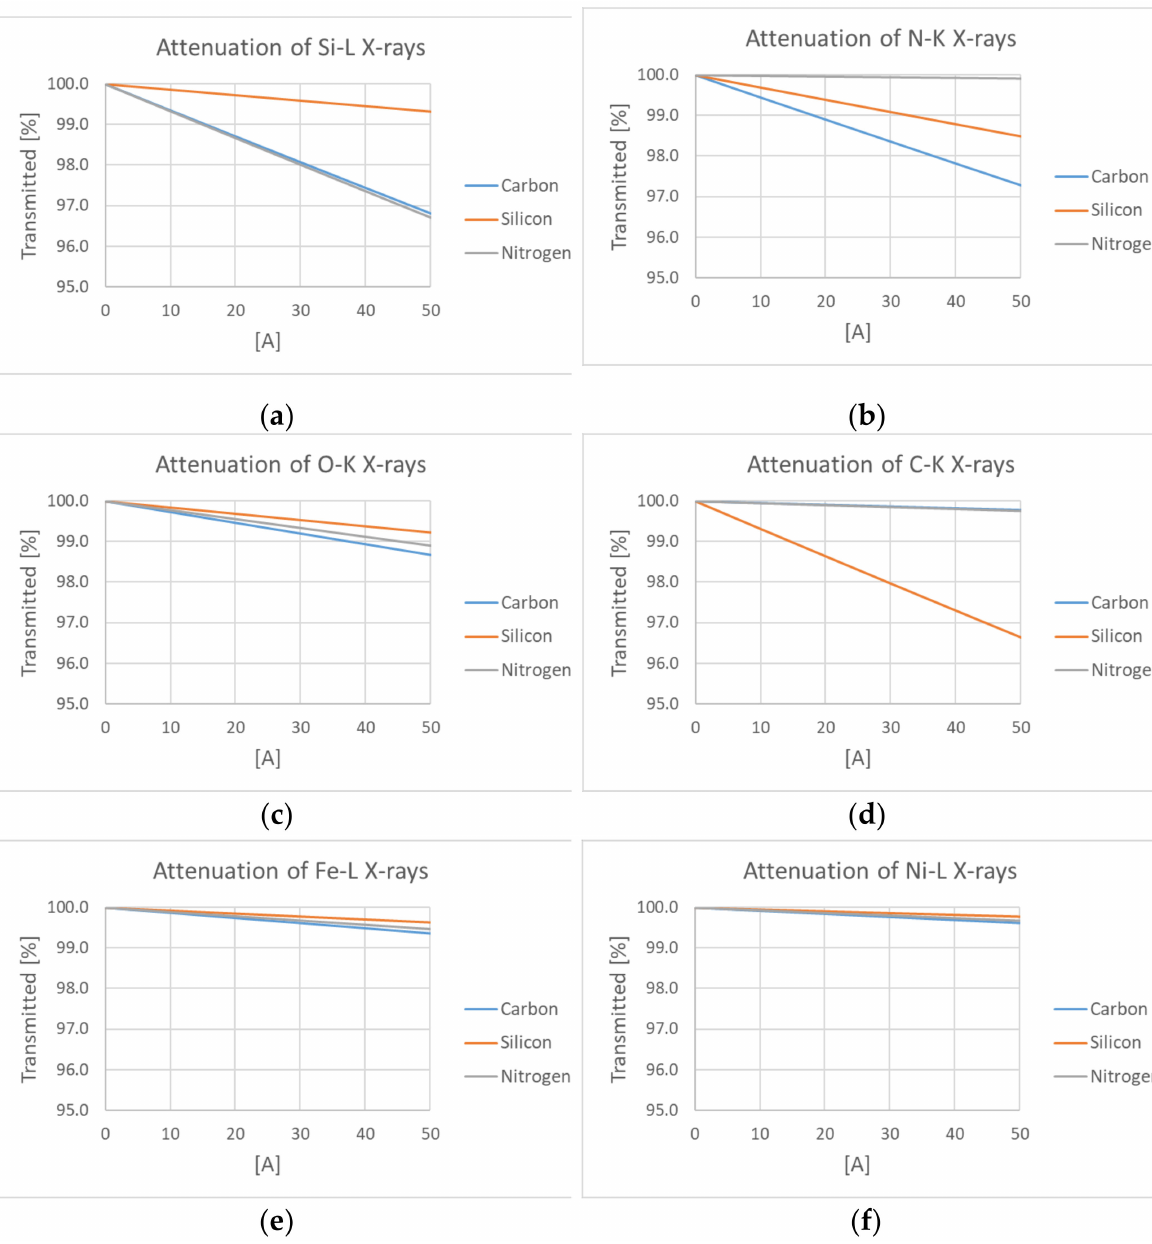
Figure 7. Attenuation of Si–L ( a ), N–K ( b ), O–K ( c ), C–K ( d ), Fe–L ( e ) and Ni–L ( f ) X-ray photons detected by the SEM/EDX method on the C (DLC), and on the Si and N potions of the SiN x (Si 3 N 4 )